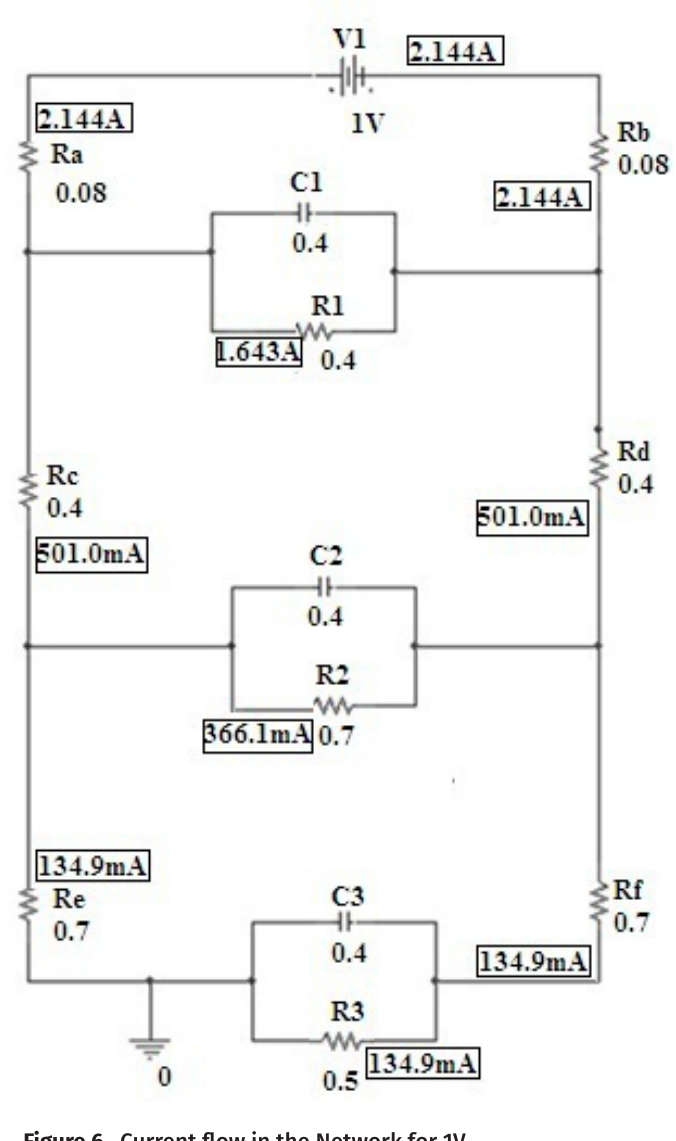
Figure 6. Current flow in the Network for